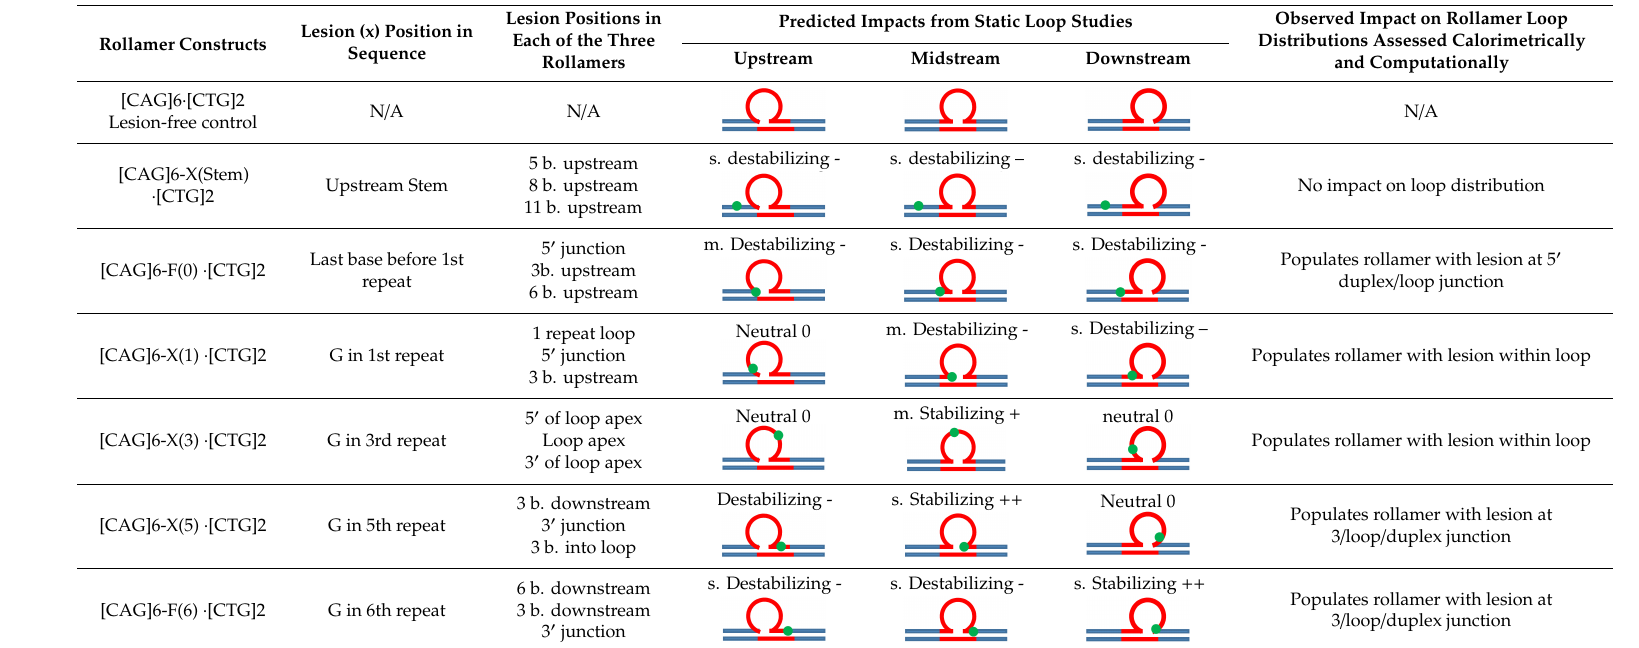
Table 1. Position-dependent, lesion (X)-induced impact on rollamer distributions in [CAG]6-X(n) ·